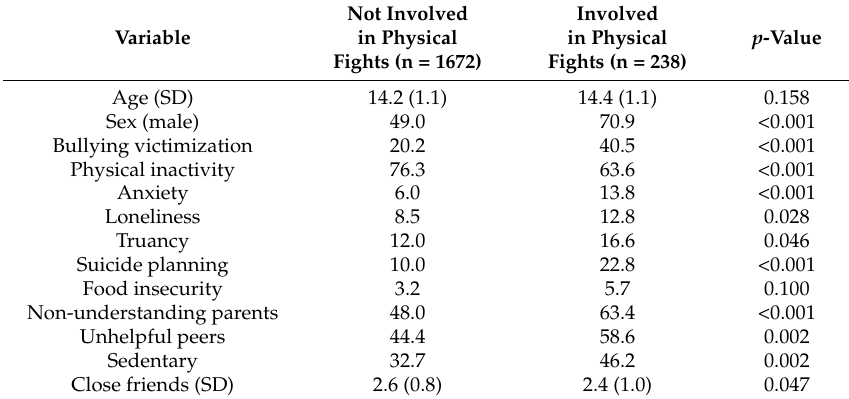
Distribution of selected factors according to categories of physical fighting among school-attending adolescents in El Salvador, GSHS